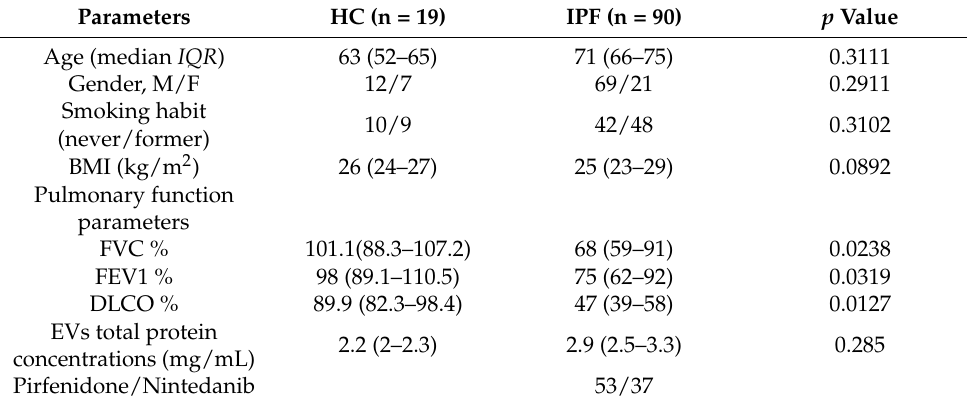
Table 1. Main characteristics of our study population including age, gender, smoking habit, BMI, LFT parameters, total protein concentrations (mg/mL, Bradford assay), and antifibrotic treatments started after a certain